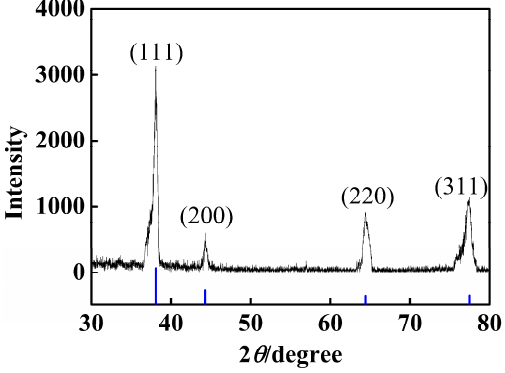
Figure 13. XRD of nAg@PSA composite nanospheres obtained from PSA0 nanospheres.